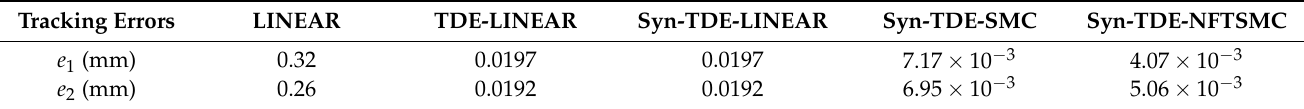
Table 3. The absolute average tracking errors (AATE) of the control schemes, computed by MATLAB.